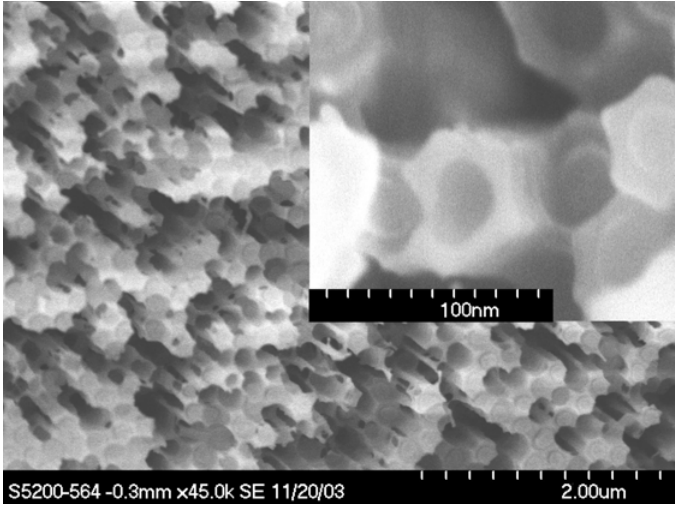
Figure 4. SEM photograph of polypyrrole nanotube